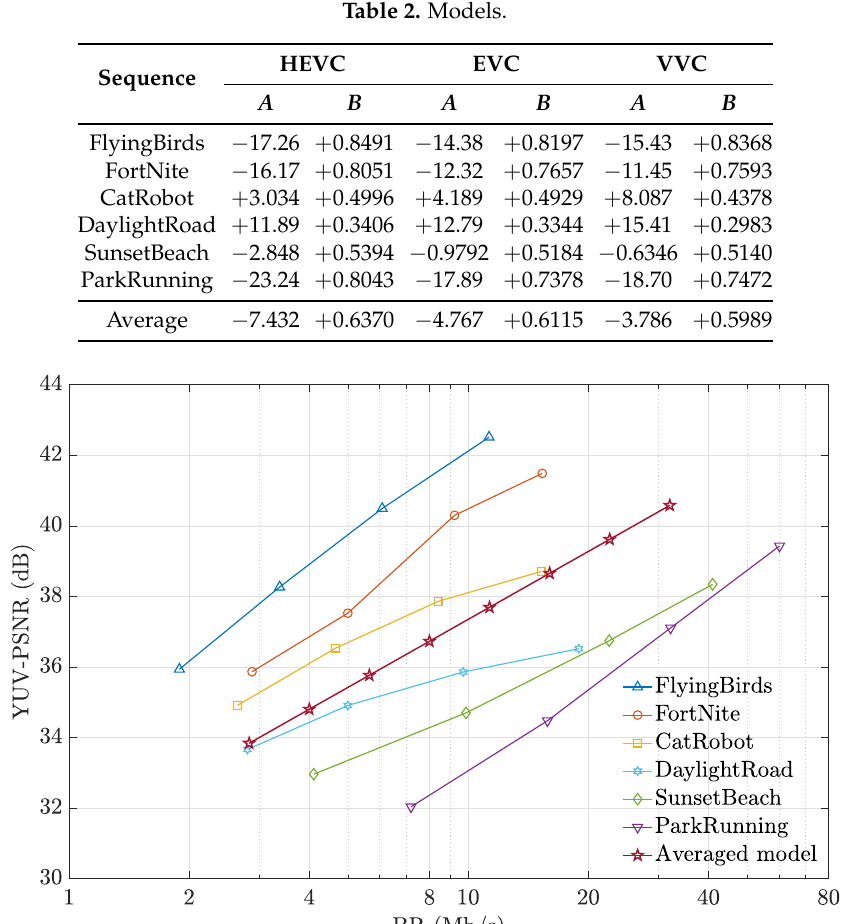
Figure 1. High Efficiency Video Coding (HEVC): PSNR–BR data and linear RD models for 3840 × 2160 resolution sequences. The averaged RD model is also displayed as red line with star